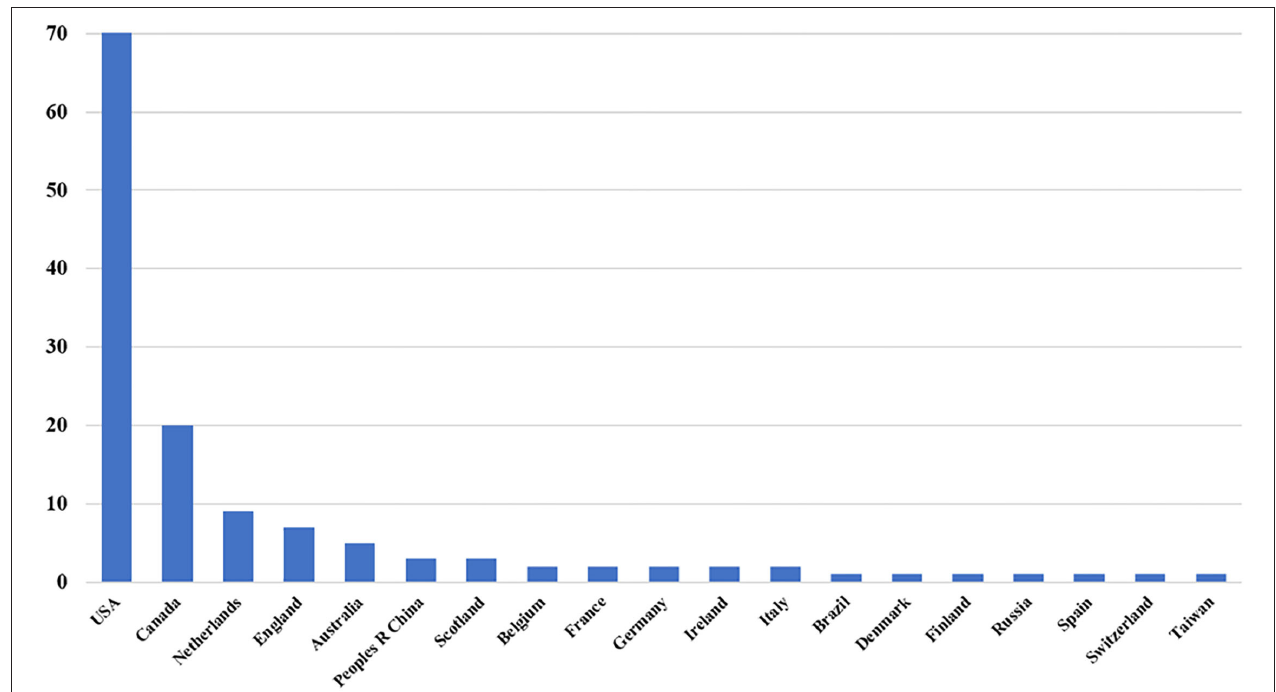
FIGURE 2 | Number of the 100 most-cited articles published by country or region.